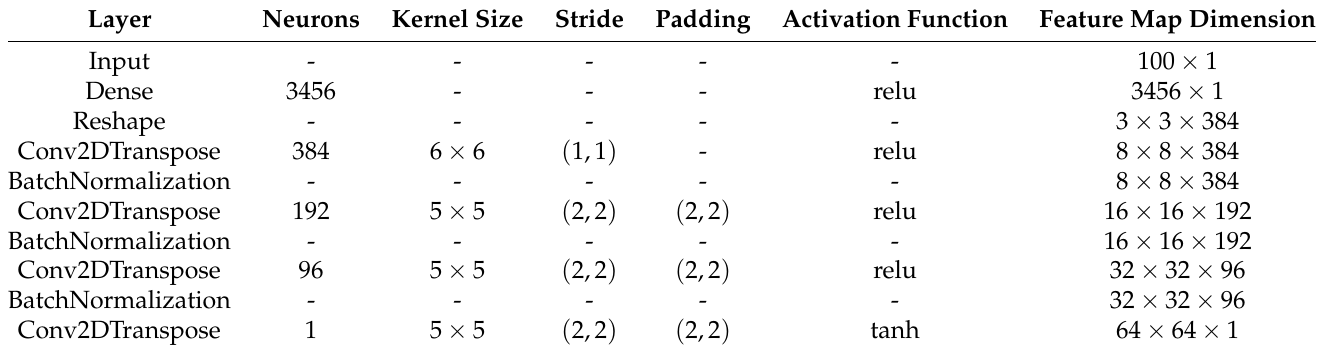
Figure 5. Training process of the TransfGAN. ( a ) The initial TransfGAN is generating noise and will be trained with ray- traced images. ( b ) The pre-trained TransfGAN produces images containing basic geometric features. ( c ) In the fine-tuning step, the discriminator needs to distinguish between the generated ray-traced images and the real sidescan sonar snippets. ( d ) Finally, the generator produces images similar to the real data. Table 3. Generator of the